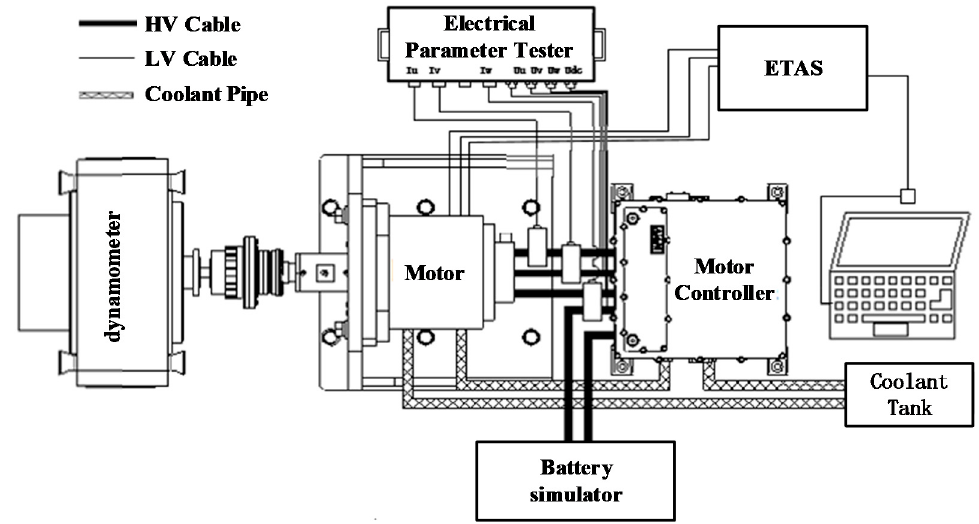
Figure 17. Schematic diagram of test bed.